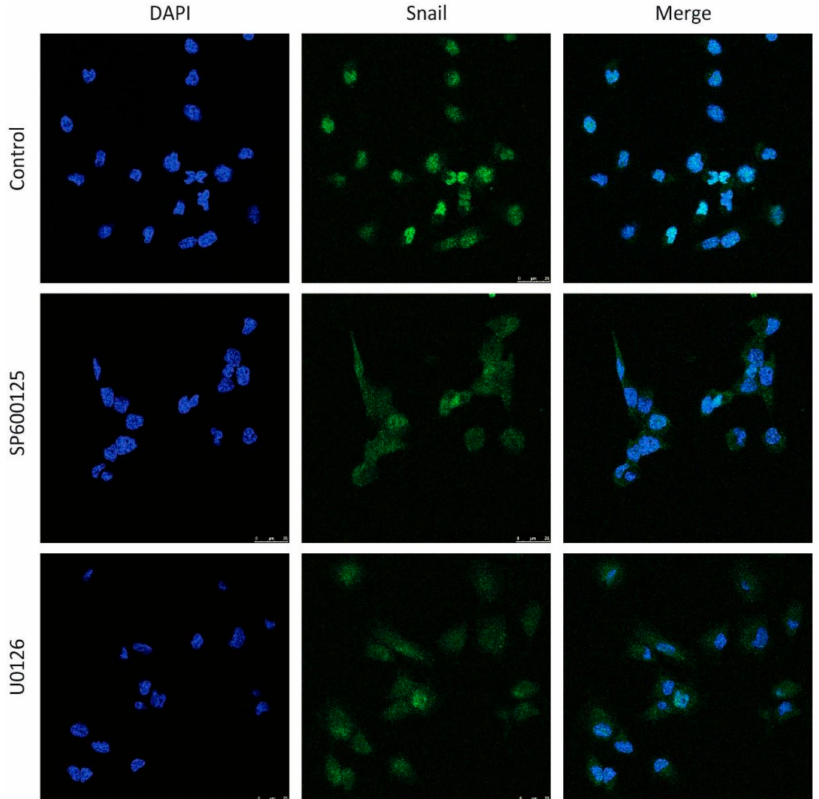
Figure 4. Snail subcellular location is regulated by the JNK and ERK signaling pathways. DU145 cells were incubated for 48 h with 10 µ M SP600125 or 20 µ M U0126 and Snail subcellular location was determined by immunofluorescence as described in Material and methods. DAPI was used to identify the nuclei. Pictures are from one representative experiment of three with similar